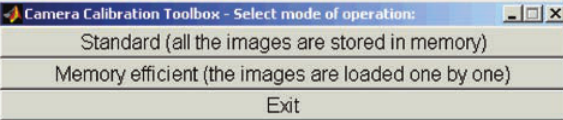
Fig. 2. The geometry model of object